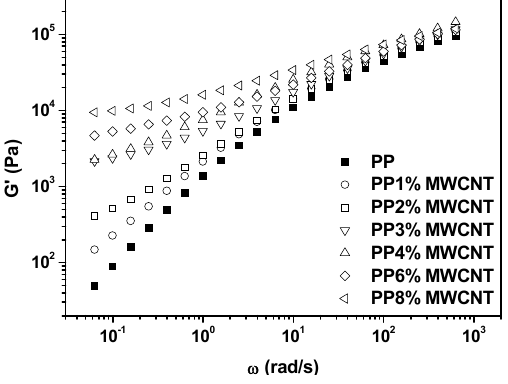
Figure 4. Storage modulus against frequency at 180 °C for neat PP and MWCNT/PP